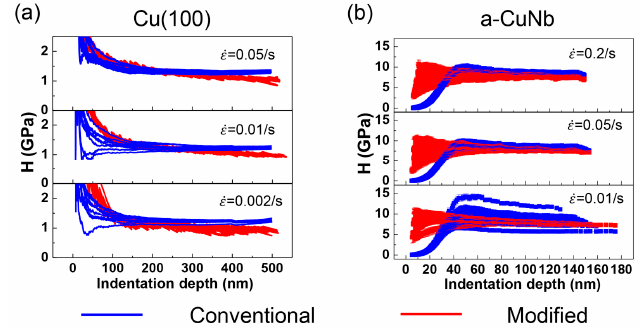
Figure 3. Comparison of nanoindentation results obtained from conventional (blue) and modified (red) methods using the same sets of indentation data at various strain rates for ( a ) Cu and ( b ) amorphous CuNb. At a high strain rate (0.05 s − 1 ), the indentation hardnesses calculated from both techniques are similar. However at low strain rate, the conventional analysis leads to more scattered results.